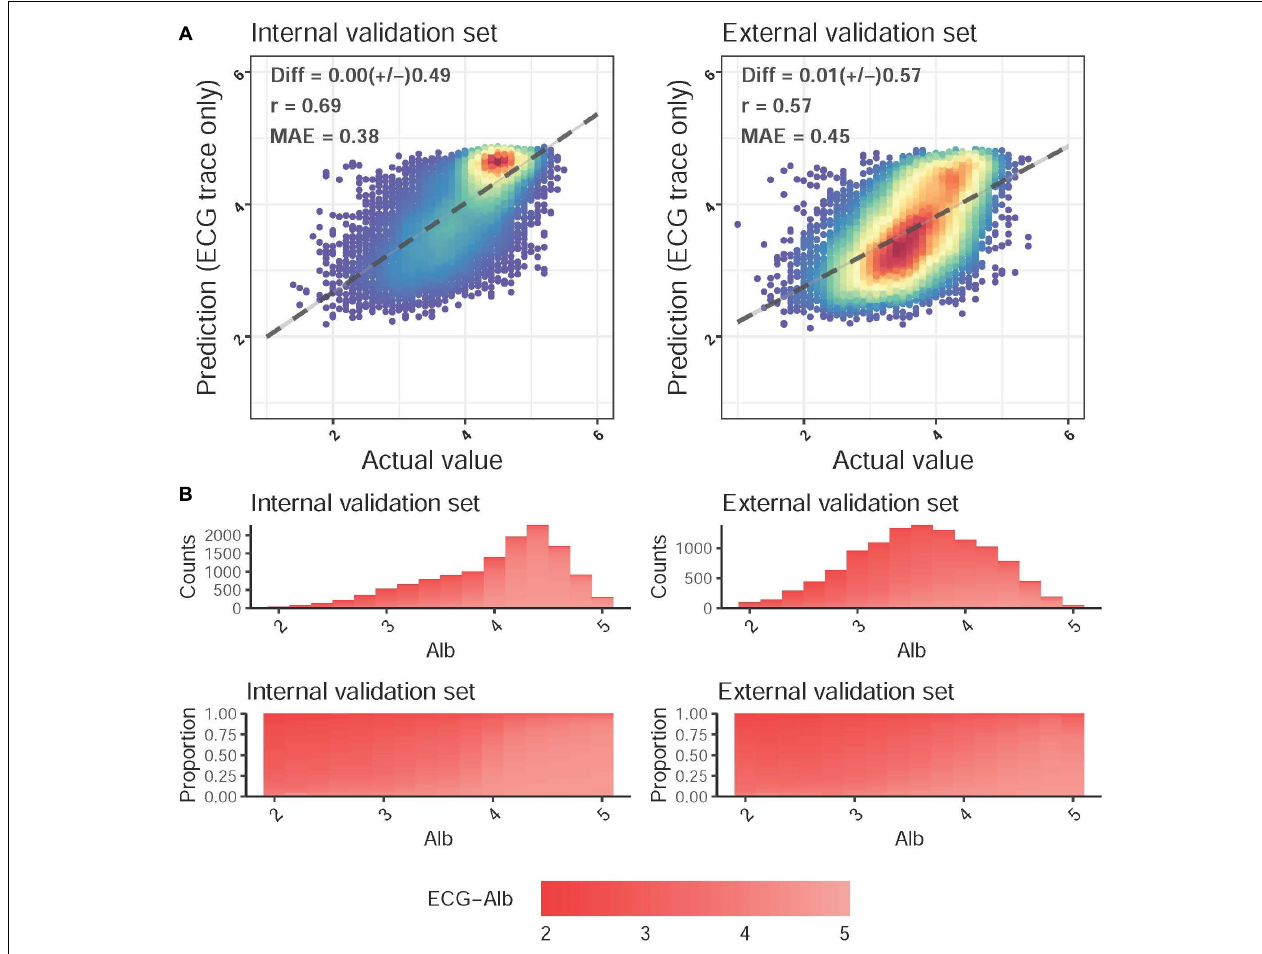
FIGURE 2 | Predicted albumin (ECG-Alb) and actual Alb. (A) Scatter plots of ECG-Alb compared to the actual Alb. The x-axis indicates the actual lab measured Alb, and the y-axis presents the ECG-Alb. Red points represent the highest density, followed by yellow, green light blue, and dark blue. We presented the mean difference (Diff), Pearson correlation coefficients (COR), and mean absolute errors (MAE) to demonstrate the accuracy of the DLM. The black lines with 95% conference intervals are fitted via simple linear regression. (B) The distributions of Alb in the internal and external validation sets. The color gradient from white to red demonstrates the ECG-Alb from normal to low. The top panel shows the original distribution of each dataset, and the bottom panel shows the distribution of ECG-Alb for each actual Alb